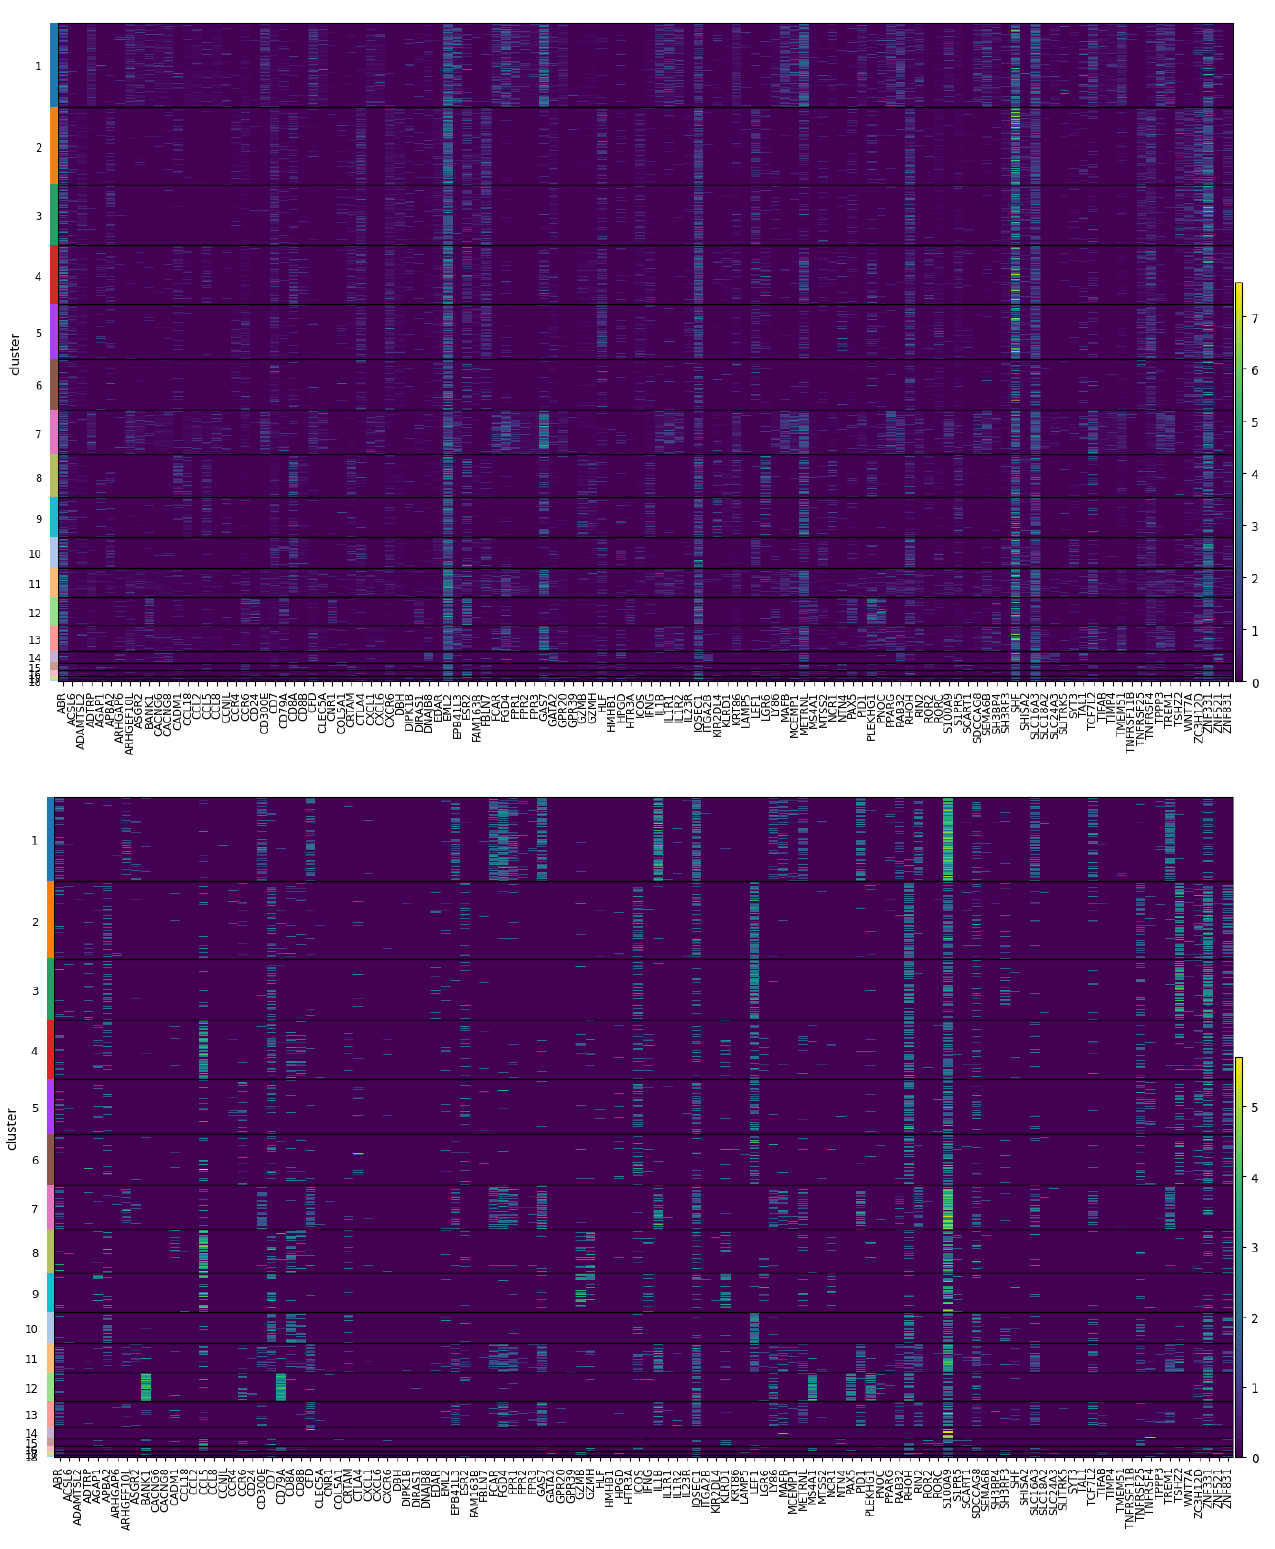
Figure 12. Heatmap for the top 10 DA genes, showing their Activity (on the top ) and Expression (on the bottom ) profiles throughout the whole 10X Multiome Chromium X PBMC dataset. Again, one can notice repeated patterns between the two, even if, in this dataset, the discrepancies are more and the correlation is less